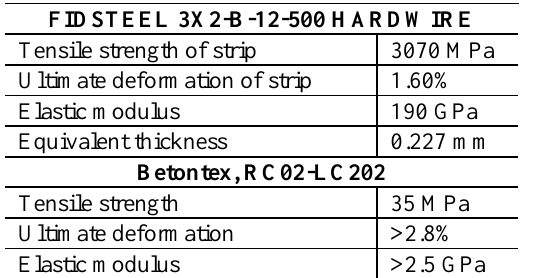
Table 3. Properties of the strengthening